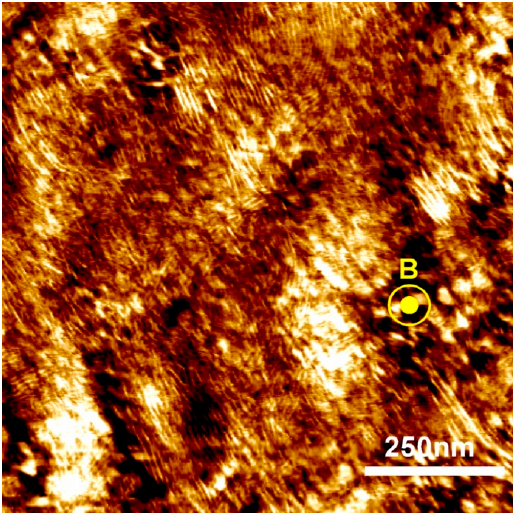
Figure 6. AFM image of PEO-b-PMA / CB cross section aligned in 6 T magnetic field applied in the direction perpendicular to the image